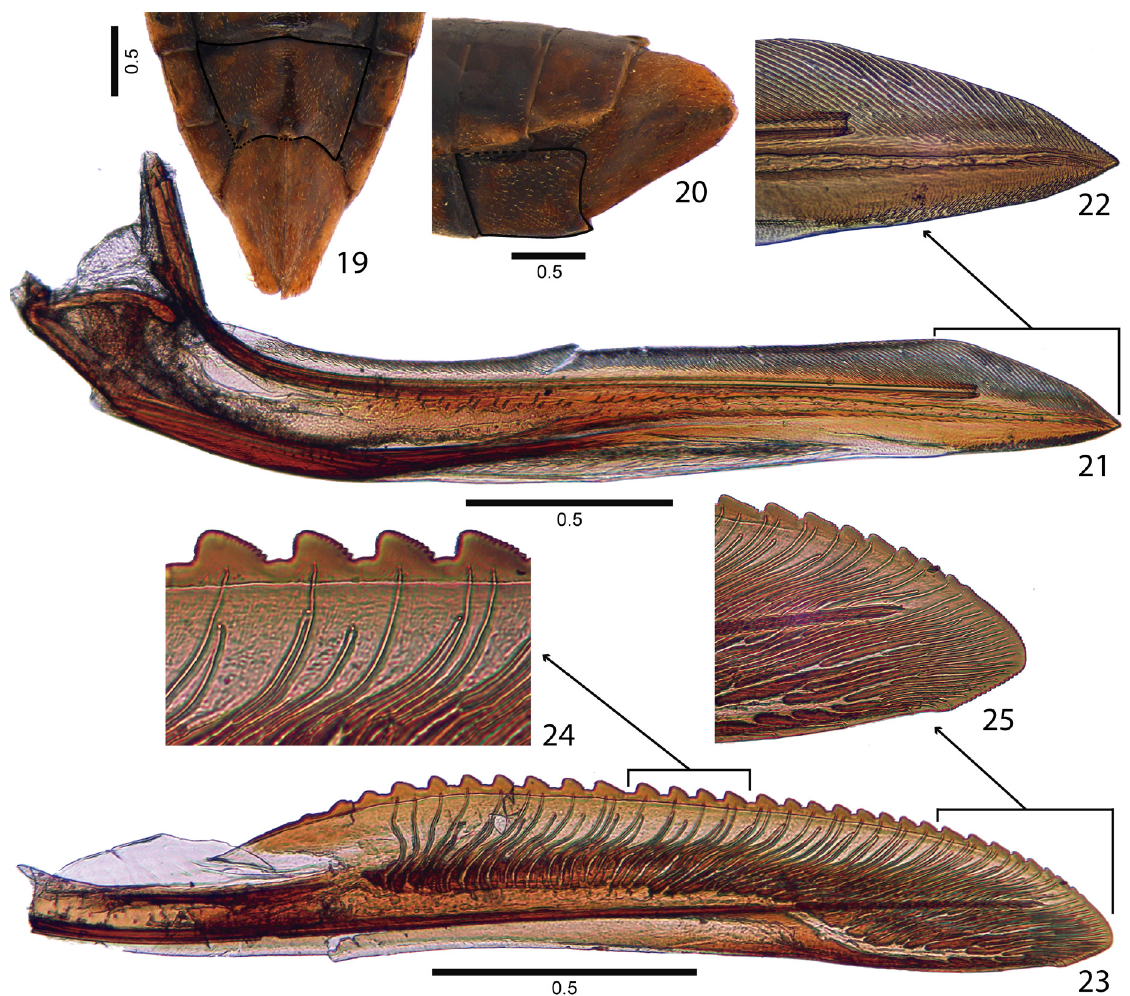
Figs 19–25. Tretogonia elegantula sp. nov., paratype, ♀ (DZUP 215387). 19 – 20 . Distal portion of abdomen (contour of sternite VII highlighted). 19 . Ventral view. 20 . Lateral view. 21 – 22 . First valvula. 21 . General lateral view. 22 . Detail of apical portion. 23 – 25 . Second valvula. 23 . General lateral view. 24 . Detail of median portion. 25 . Detail of apical portion. Scales in